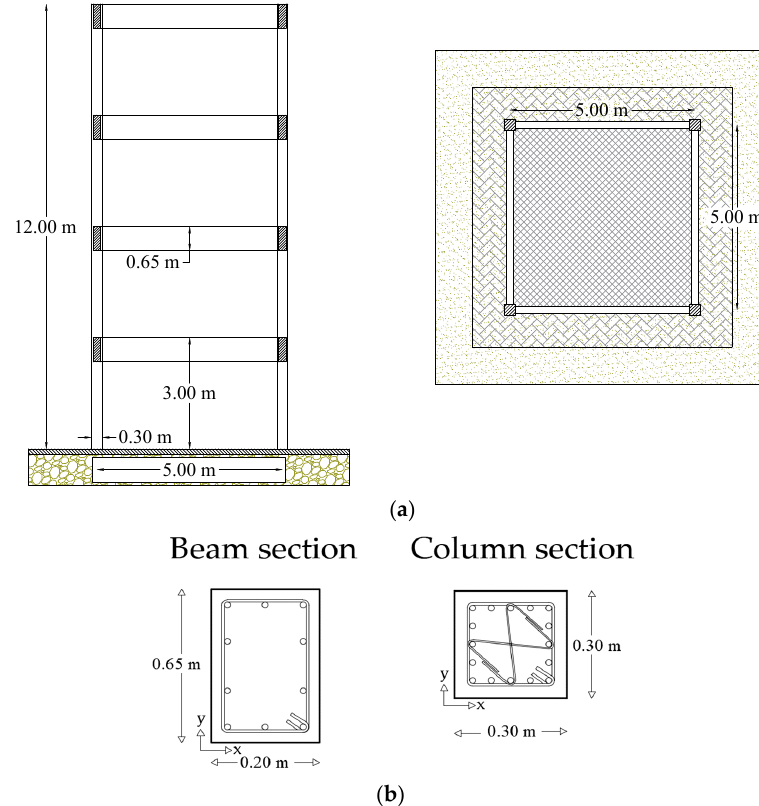
Figure 2. Structure lateral view and cross section ( a ), beam and column cross section ( b ). Table 1. Location of the considered construction sites for the structure.